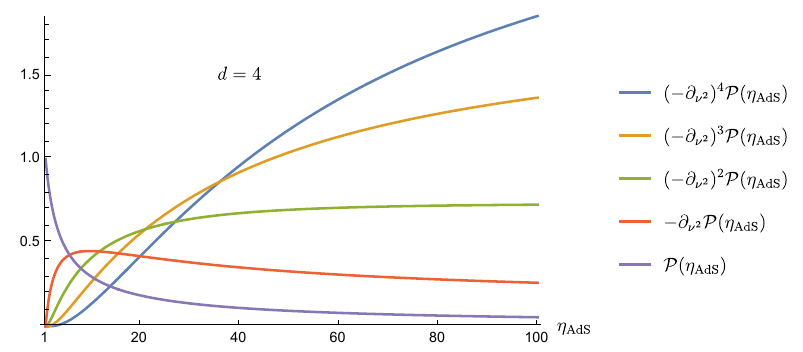
) n P (cosh β ) (cid:12) (cid:12) are positive 2 − d ν 2 + iν ν =0 2